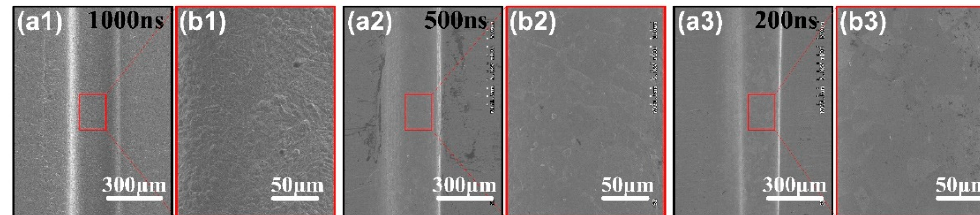
Figure 10. ( a1 – a3 ) SEM images of the micro-groove profiles with the pulse width of 200 ns, 500 ns and 1000 ns. ( b1 – b3 ) SEM images of the surface quality with corresponding pulse width.